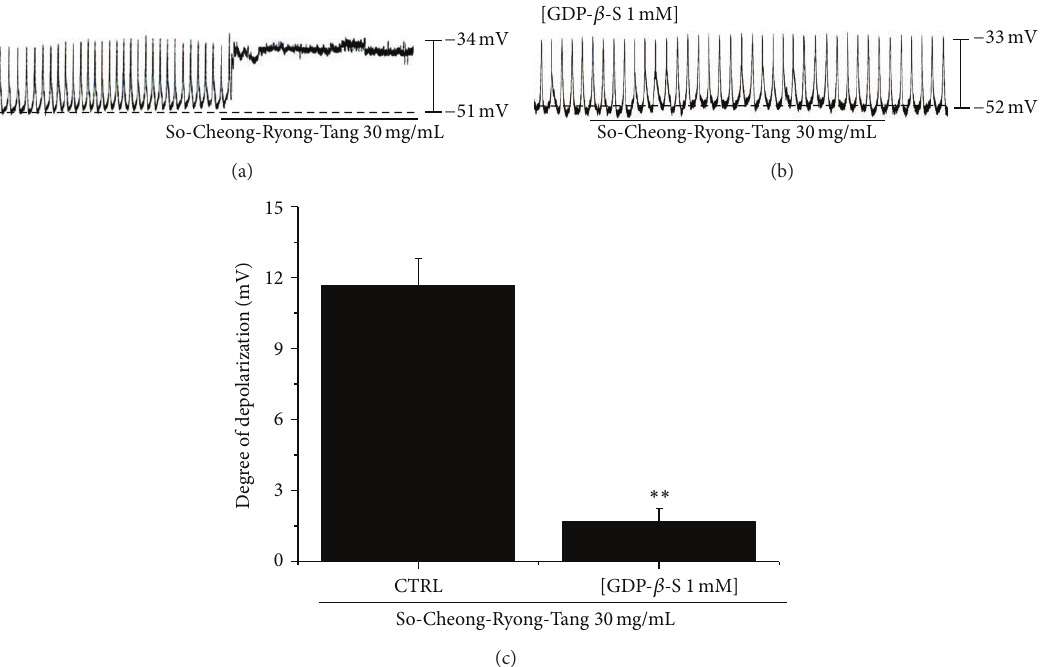
Figure 3: Effects of GDP- 𝛽 -S in the pipette on SCRT-induced pacemaker potentials in cultured ICCs of murine small intestine. (a) SCRT (30 mg/mL) induced membrane depolarizations on ICCs. (b) Pacemaker potentials of ICCs exposed to SCRT (30mg/mL) in the presence of GDP- 𝛽 -S (1mM) in the pipette. Under these conditions, SCRT (30 mg/mL) caused membrane depolarization. (c) Responses to SCRT in the presence of GDP- 𝛽 -S in the pipette are summarized in (b). Bars represent mean values ± SEs. ∗∗ 𝑃 < 0.01 . Significantly different from untreated controls. CTRL: